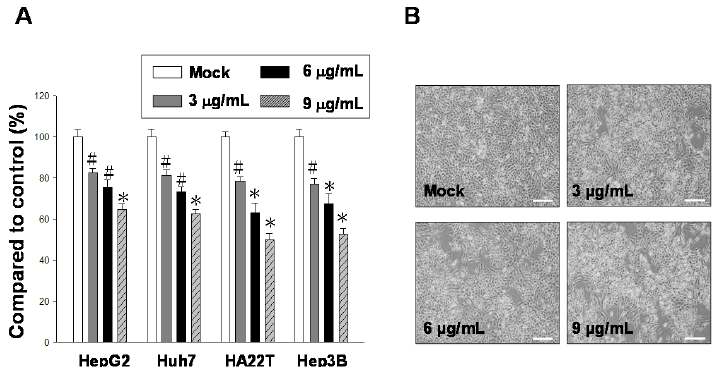
Figure 2. Administering 11- epi -SA treatment to HA22T hepatoma cells causes cytotoxic effects. ( A ) Investigation of the cytotoxic effect of 11- epi -SA on human hepatoma cell lines. Four human hepatoma cell lines (HepG2, Huh7, HA22T, and Hep3B) were treated with dimethyl sulfoxide (DMSO) (mock control) or various concentrations of 11- epi -SA for 24 h, followed by the examination of cell viabilities by using the 3-(4,5-dimethylthiazol-2-yl)-2,5-diphenyltetrazolium bromide (MTT) assay as described in the Materials and Methods section. The DMSO-treated cells exhibited 100% viability. 11- epi -SA exerts a considerable cytotoxic effect on HA22T cells. The results shown here are representative of three independent experiments (# p < 0.05; * p < 0.01); ( B ) Morphological changes of the HA22T cells on 11- epi -SA treatment. HA22T cells were treated with DMSO (Mock) or 11- epi -SA at final concentrations of 3, 6, and 9 μ g/mL. Scale bar: 50 μ m.